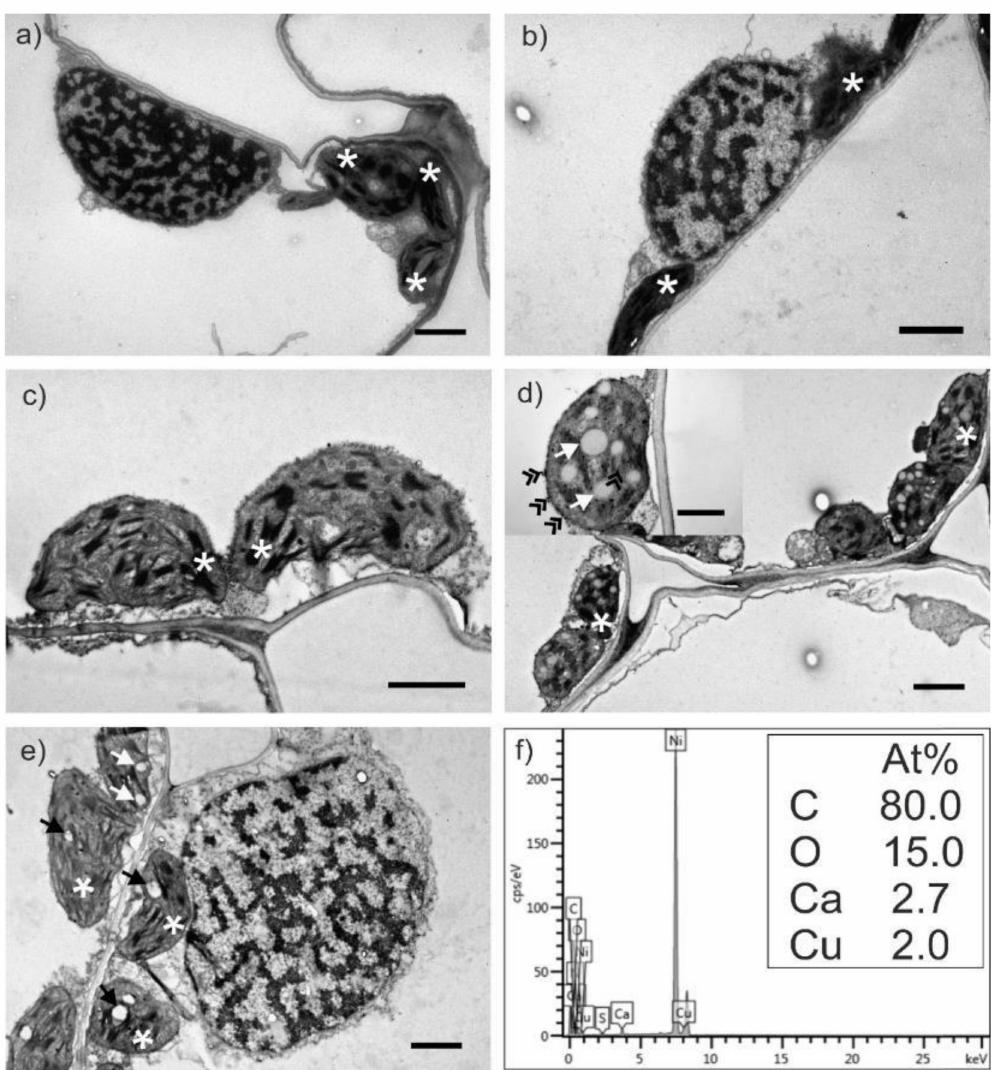
Figure 6. TEM micrographs of Triticum aestivum leaves treated with CuSO 4 solution: 60 mg at three weeks ( a ) and six weeks ( b ), and 120 mg at three weeks ( c ) and six weeks ( d ); untreated control leaves ( e ); EDX analysis of 120 mg treated plants for six weeks ( f ) indicating Cu accumulations in the electron dense particles (double arrowheads). After six weeks the wheat plants start to develop starch granules (simple arrow) inside the chloroplasts (asterix). All bars are at 2 µ m; inset with bar at 1 µ m ( d